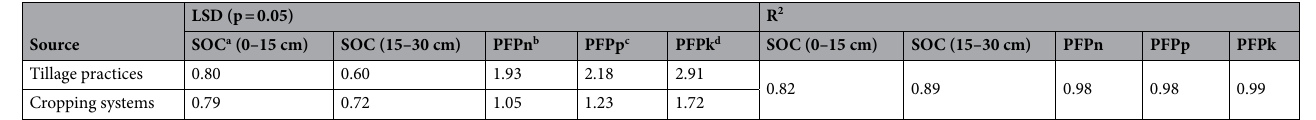
Table 6. ANOVA for a soil organic carbon, b partial factor productivity of N, c partial factor productivity of P, and d partial factor productivity of K.